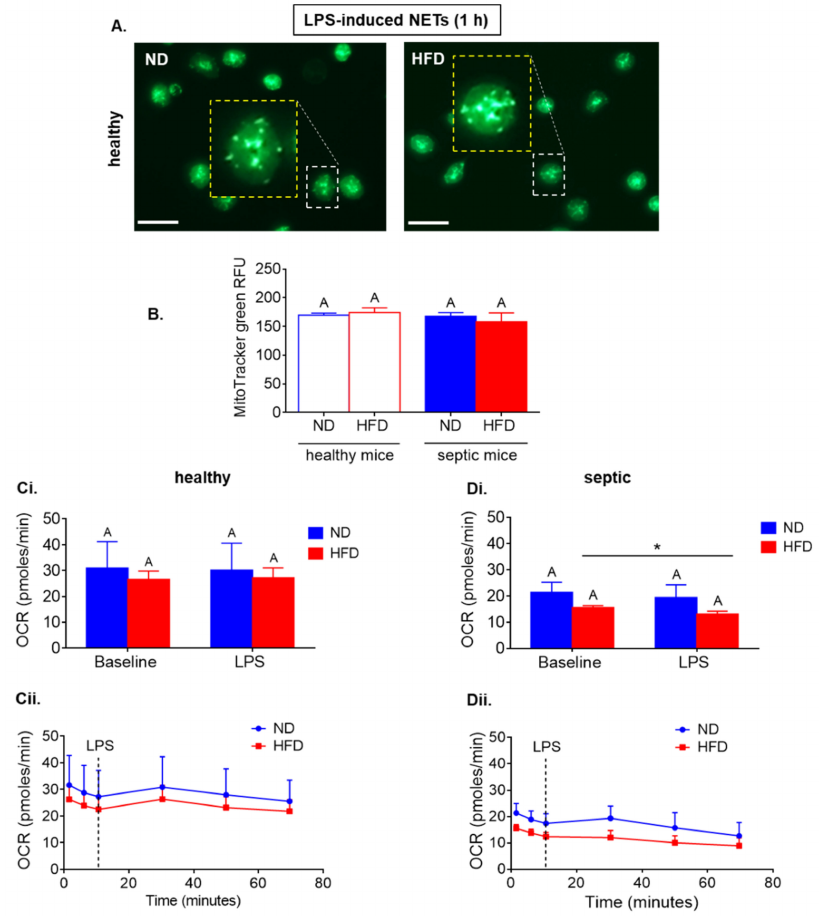
Figure 3. Comparison of mitochondria counts and metabolic activity between neutrophils isolated from obese mice due to high fat diet (HFD) and their lean controls (ND) in a healthy state and with ongoing sepsis. Neutrophils were collected from ND and HFD mice that were either healthy (not treated in any way) or with an ongoing systemic inflammation/endotoxemia induced 24 h prior to neutrophil isolation by injecting animals with 1 mg/kg body weight of lipopolysaccharide (LPS). Metabolic parameters were measured within one hour since cell seeding or ex vivo activation with LPS. Mitochondria were visualized upon staining (MitoTracker green-positive organelles) of neutrophils. Scale bars indicate 20 µ m. Representative images for healthy mice are shown ( A ), and data quantification for both healthy and septic mice is shown in ( B ) (RFU, relative fluorescence units). Metabolic parameters were measured with a Seahorse analyzer ( C , D ). Data quantification of Oxygen Consumption Rate (OCR) ( Ci , Di ) and representative Seahorse readouts ( Cii , Dii ) are presented where C corresponds to neutrophils isolated from healthy mice, and D to their origin from septic mice, respectively. Asterisk indicates significant differences between groups according to unpaired two-tailed Student’s t -test (* p ≤ 0.05). Results of one-way ANOVA (post hoc Bonferroni): means that share same letter are not significantly different. Data are shown as mean ± s.d.; n ≥ 3 per